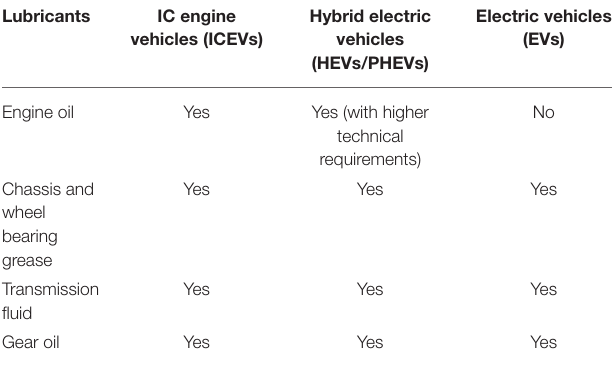
TABLE 3 | Lubricants used in ICEV, HEV, and EV. Lubricants IC engine vehicles